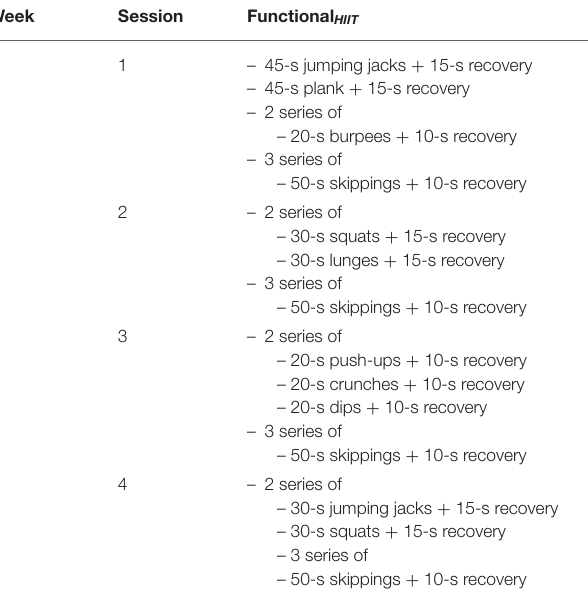
TABLE 2 | Details of the 4-week Functional HIIT training intervention. Week